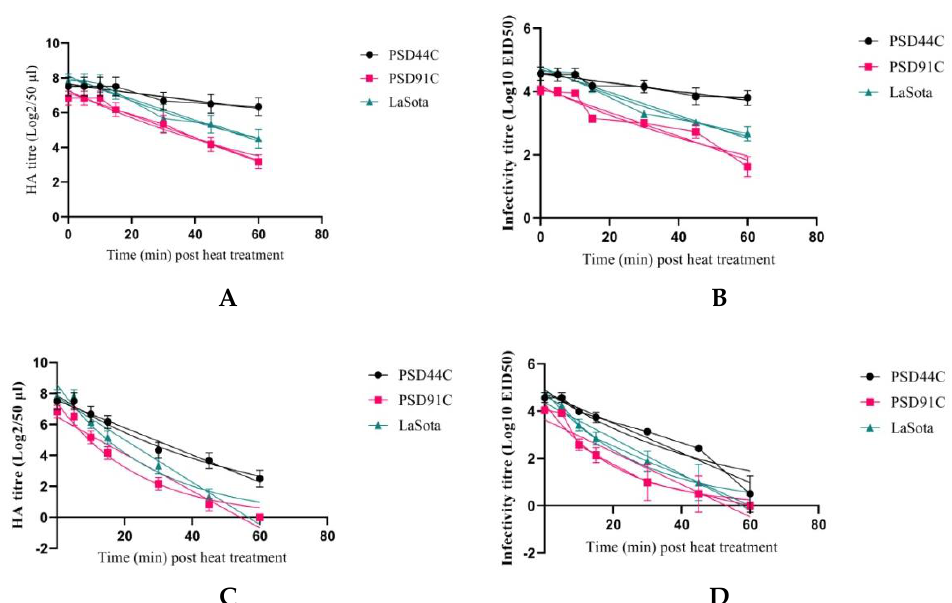
Figure 5. Hemagglutinin (HA) stability (Log 2 HA) and infectivity titer (Log 10 EID 50 ) of chicken- adapted PSD44C, PSP91C and LaSota strain at different temperature-time intervals ( A : HA activity at 40 °C, B : Infectivity at 40 °C, C : HA activity at 56 °C, D : Infectivity at 56 °C).